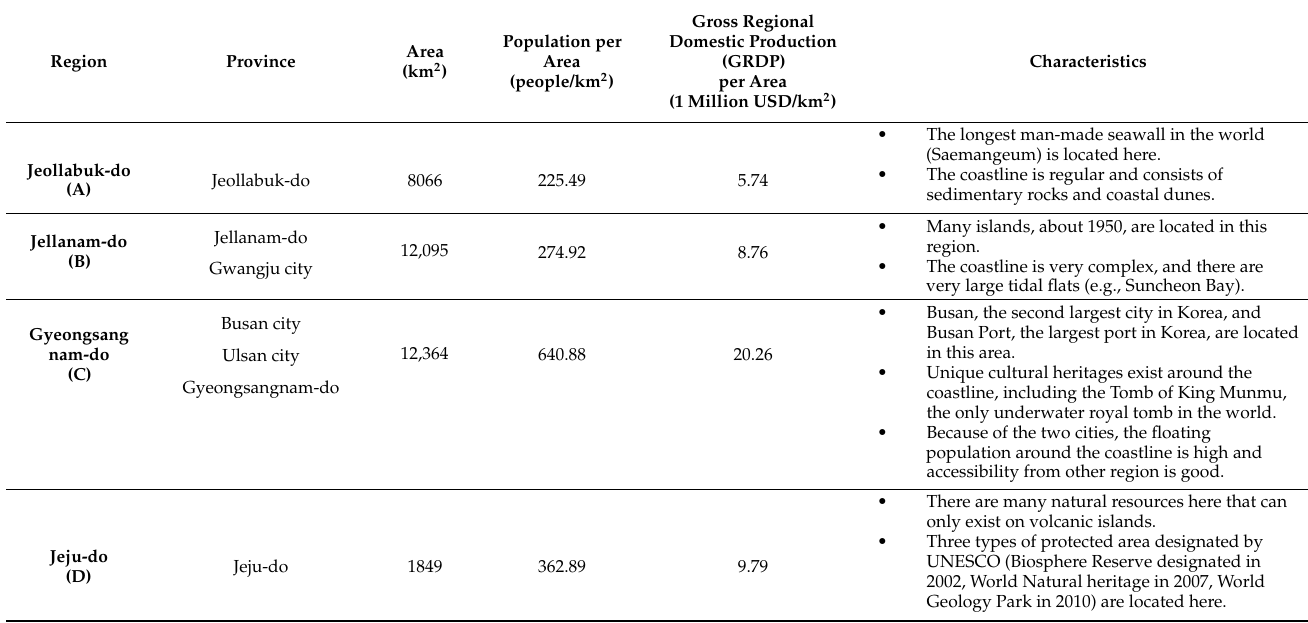
Table 1. Characteristics of the four regions